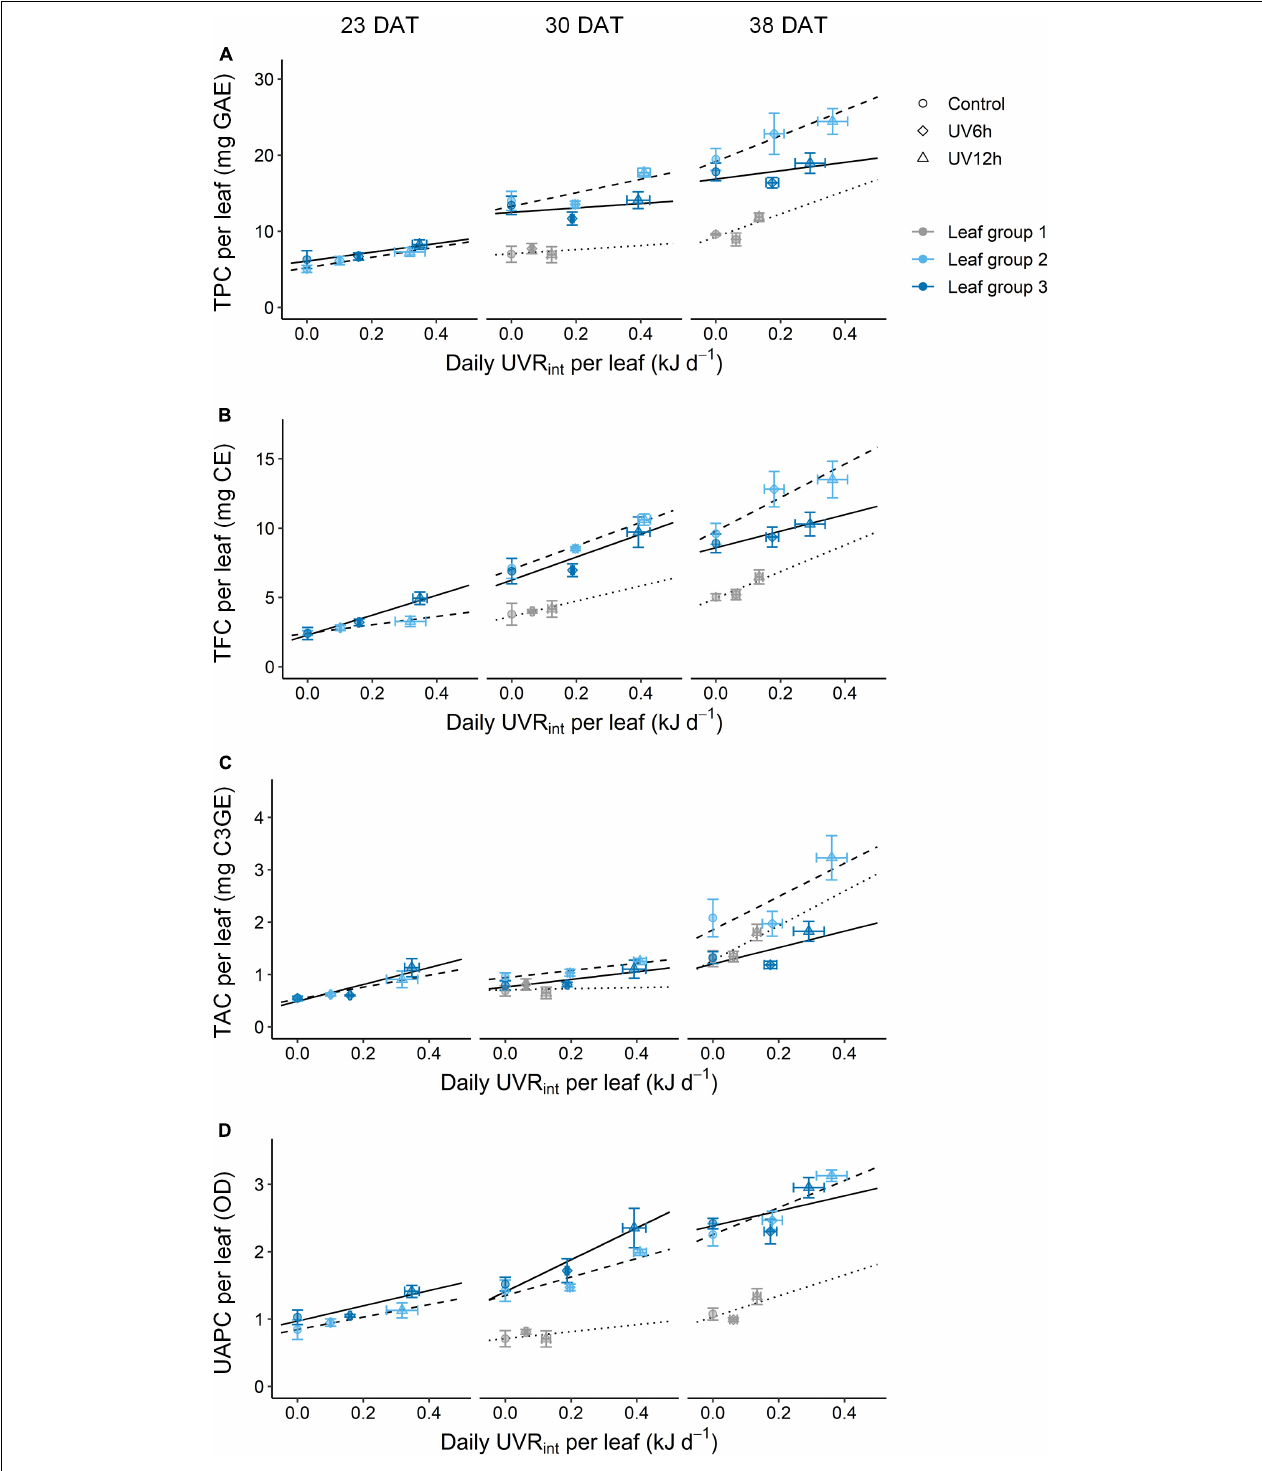
FIGURE 6 | Relationships between phenolic content and the daily UV-B radiation interception (UVR int ) per leaf of kales according to leaf group at 23, 30, and 38 days after transplanting (DAT); total phenolic content (TPC, A) , total flavonoid content (TFC, B) , total anthocyanin content (TAC, C) , and UV-absorbing pigment content (UAPC, D) in individual leaves. Leaf groups were determined according to the order of leaf emergence and their relative growth state ( Supplementary Figure 3 and Supplementary Table 1 ). The vertical and horizontal bars indicate SE ( n = 4). The lines show linear fits of the leaf group 3, 2, and 1 data sets (solid, dashed, and dotted